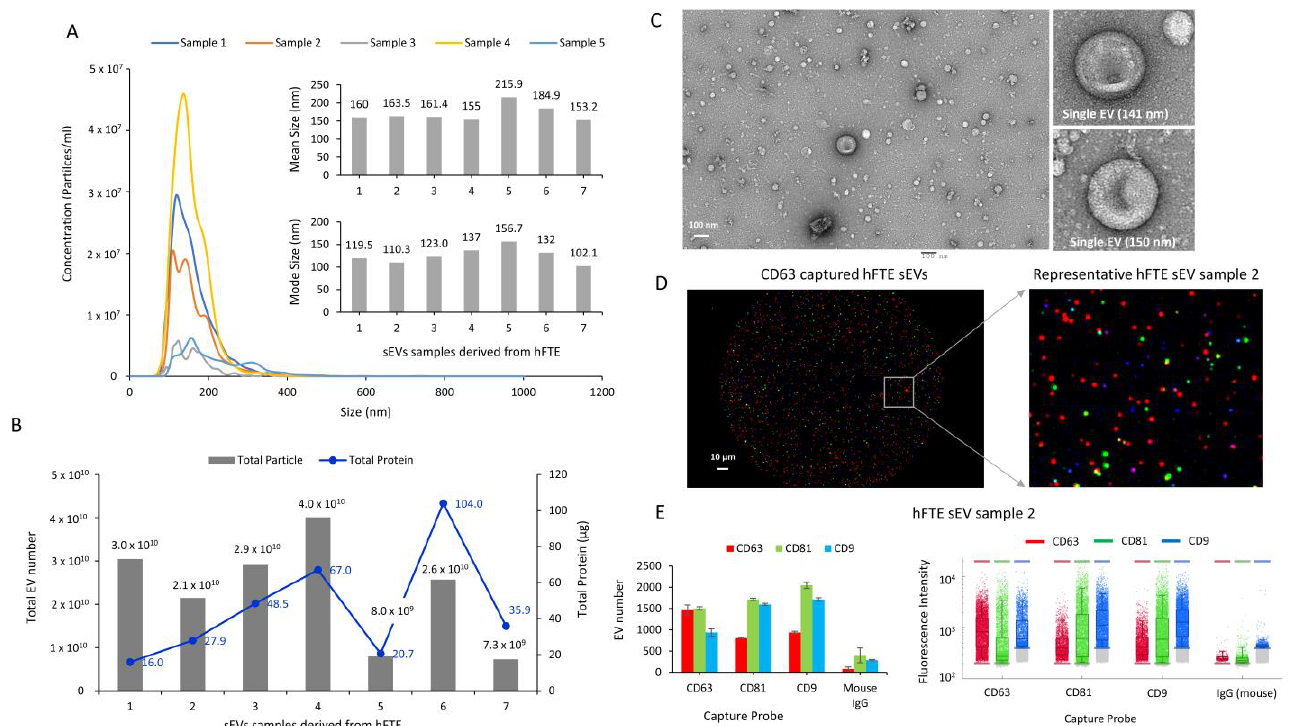
Figure 2. The physical and molecular characterization of sEVs derived from hFTE cultured in the PREDICT-MOS. ( A ) The size profile of sEVs was quantified using nanoparticle-tracking analysis (NTA). NTA graphs of five representative samples are shown. Inset shows the mean size and mode size of sEVs from seven patient samples. ( B ) The total sEV number and total protein content in sEVs quantified via NTA and the Bradford assay, respectively. ( C ) The transmission electron microscopy (TEM) image of sEVs shows cup-shaped morphological properties. Inset shows the micrograph of a single sEVs (Scale bar: 100 nm). ( D ) The image of sEVs captured by the CD63 capture probe in ExoView chip, and detected by CD63 (red), CD81 (green), and CD9 (blue) antibodies (Scale bar: 10 µ m). ( E ) The molecular characterization of sEVs quantifying CD63/CD81/CD9-positive sEVs using the ExoView platform. The graph shows the particle number and fluorescent intensity of sEVs captured by the CD63/CD81/CD9 probe, and detected by CD63/CD81/CD9 fluorescent antibodies in representative sEV